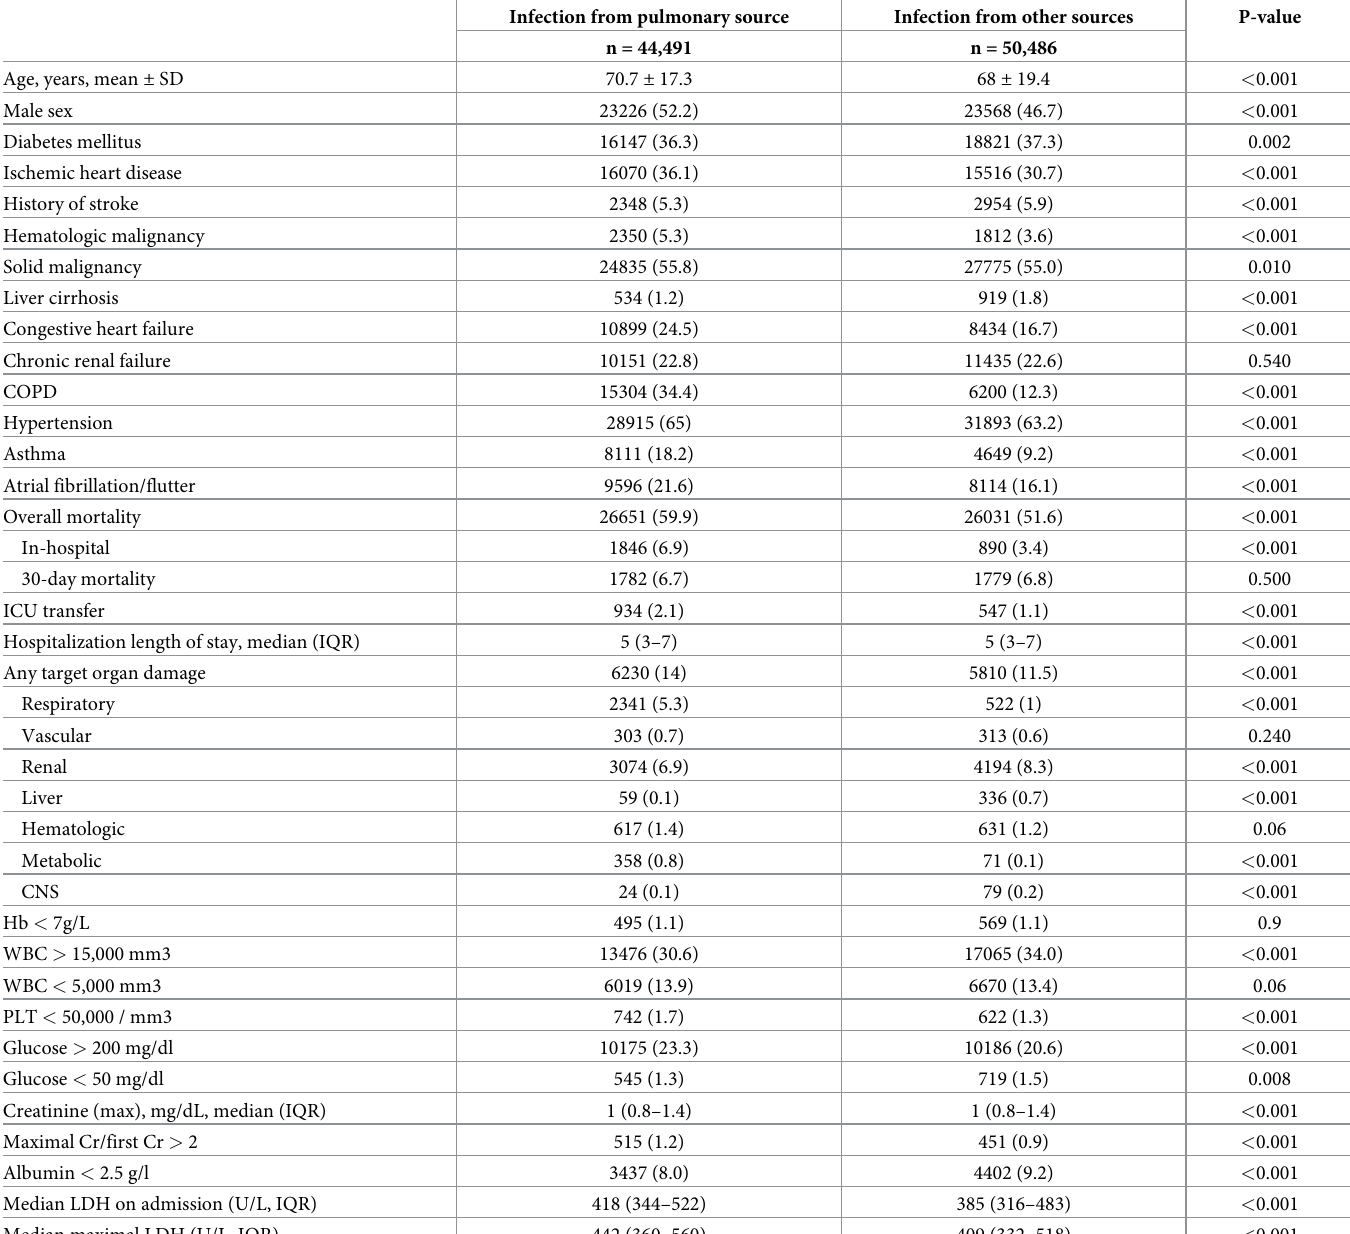
Table 1. Demographic characteristics and hospitalization